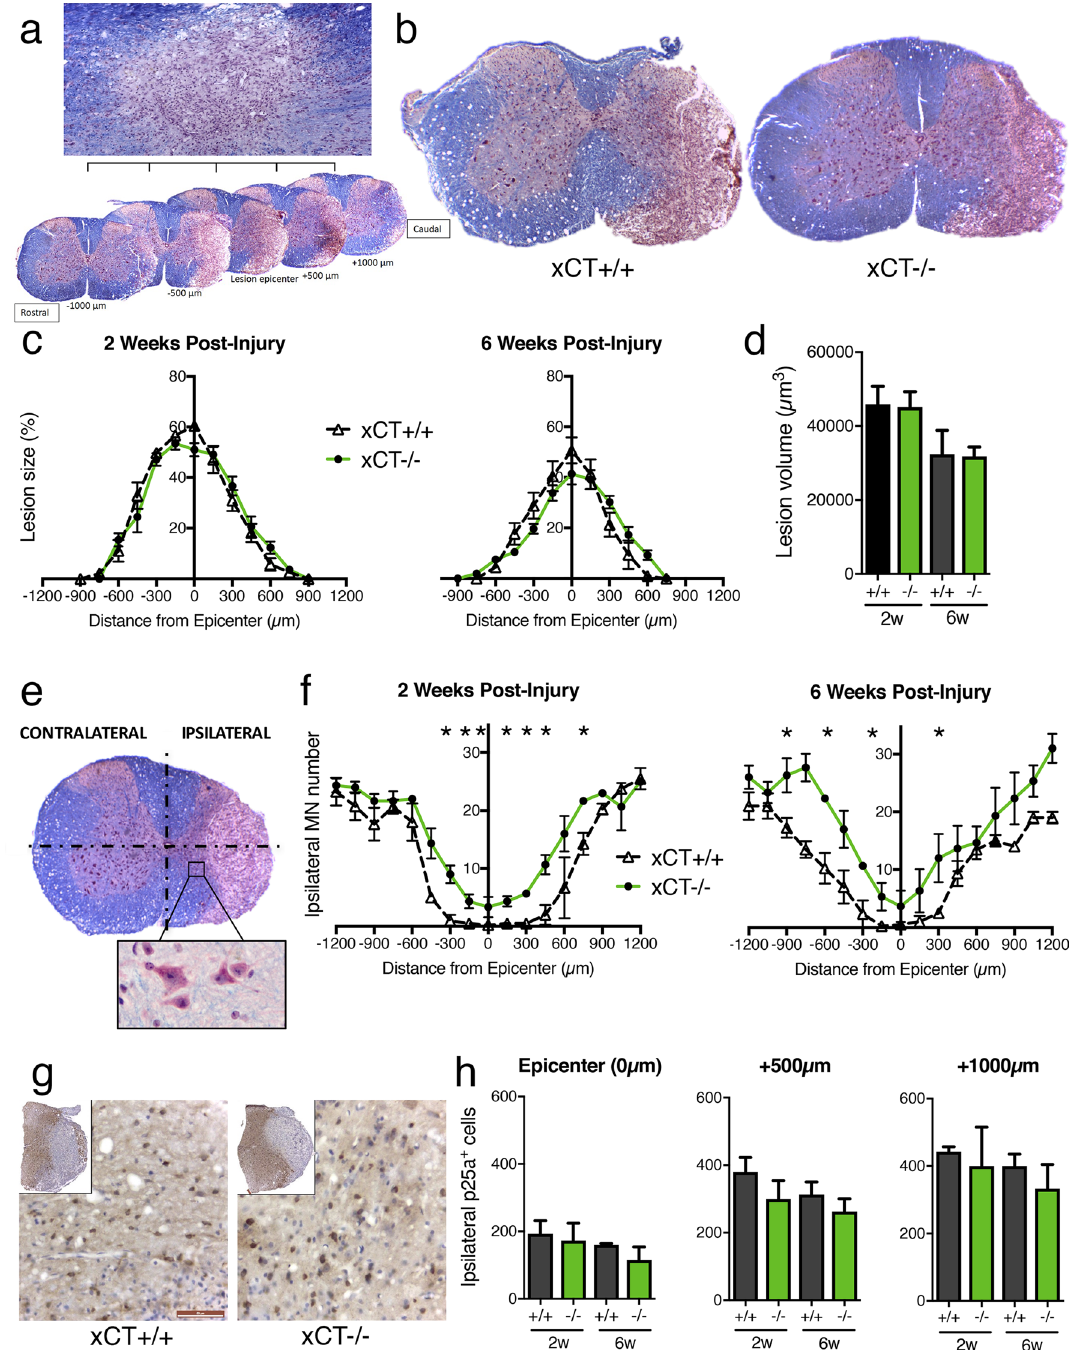
Figure 4. Quantification of lesion size, motor neuron and oligodendrocyte number in injured xCT+/+ and xCT−/− spinal cords. The diagram depicts how the unilateral lesion extends rostro-caudally from − 1000 to + 1000 µm around the epicenter ( a ). The epicenter (set at 0 µm) was defined as the spinal level where the area of lesioned tissue is maximal. Representative micrographs of the lesion epicenter is shown for xCT+/+ (left) and xCT−/− (right) mice ( b ). Quantification of lesioned area (in percentage of ipsilateral hemicord) or lesion rostro-caudal extension did not show any difference between groups at 2 or 6 weeks post-injury ( c ). Quantification of lesion volume did not show any difference between groups at 2 or 6 weeks post-injury ( d ). As depicted, the number of spared motor neurons was counted in the inferior quadrants of both contralateral and ipsilateral sides, including the ventral horn and part of the intermediate column ( e ). For some distances along the lesion, ipsilateral motor neuron number was significantly higher in injured xCT−/− mice than in the xCT+/+ mice, at both 2 and 6 weeks post-injury ( f ). Data are expressed as mean +/− SEM. * p < 0.05, Mann–Whitney test, n = 3–4 mice/group. Using anti-p25a immunohistochemistry, the number of spared oligodendrocytes was evaluated in the injured xCT+/+ and xCT−/− hemicords, at three distances from the epicenter, 0 µm, + 500 µm and + 1000 µm ( g , h ). two-way ANOVA followed by Sidak multiple comparisons test, n = 3–4 mice/group. Data are expressed as mean +/− SEM. Scale bars = 50 µm in panel